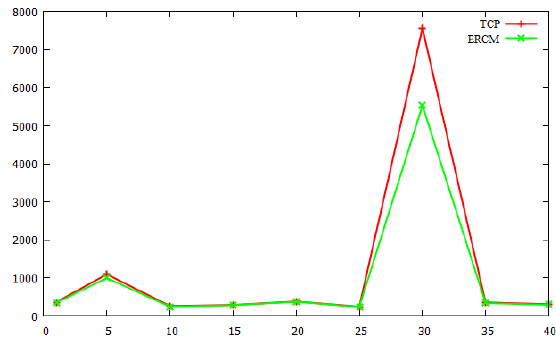
Fig. 5. Congestion loss vs. Mobility for 60 flows